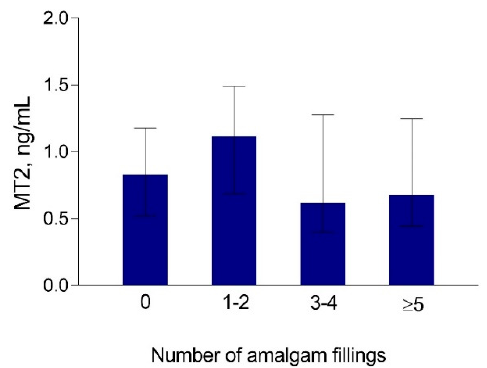
Figure 7. Concentrations of MT2 in maternal serum in the study participants from the coast ( n = 94) related to the number of amalgam fillings. Subgroups: 0—no amalgams ( n = 27); 1–2—1 to 2 amalgams ( n = 29); 3–4—3 to 4 amalgams ( n = 26); ≥ 5—5 or more amalgams ( n = 12). Data are presented as median and 25–75% interquartile range.